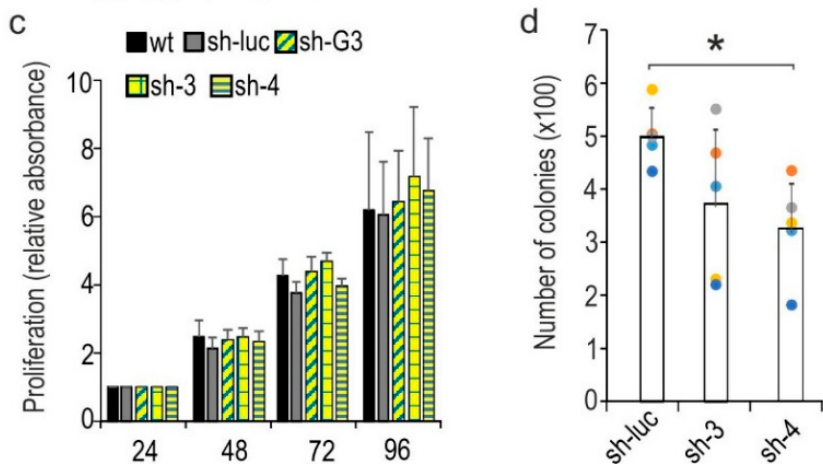
Figure 2. HSPA2 silencing in the immortalized bronchial epithelial BEAS-2B cell line. ( a ) Immunoblots show the protein levels of HSPA2, HSPA1, and HSPA8 in wild type (wt); control sh-luc cells transduced with non-targeting shRNA-luc sequence; sh-G3, sh-3, and sh-4 cells transduced with HSPA2-targeting shRNAG3, shRNA3, or shRNA4 sequences, respectively. Numbers below each lane represent the protein ratio normalized to the actin level. Representative immunoblots are shown ( n = 4; molecular weight in kDa is indicated); actin was used as a protein loading control. ( b ) Cell metabolic activity was tested using the MTS assay. Results are expressed as mean ± SD ( n = 4, each in three technical repeats) in relation to values obtained at 24 h after plating. ( c ) Cell proliferation during 24–96 h of growth was examined using crystal violet staining assay ( n = 4; each in three technical repeats). ( d ) Results of colony formation assay. Cells were plated onto six-well dishes (1.5 × 10 3 cells / well) and cultured for 7 days. Colonies were counted manually (mean ± SD, n = 5, each in three technical repeats). Each dot color represents results of one of five independent experiments. * p < 0.05 versus sh-luc cells, statistical significance was calculated using the two-tailed t -test.